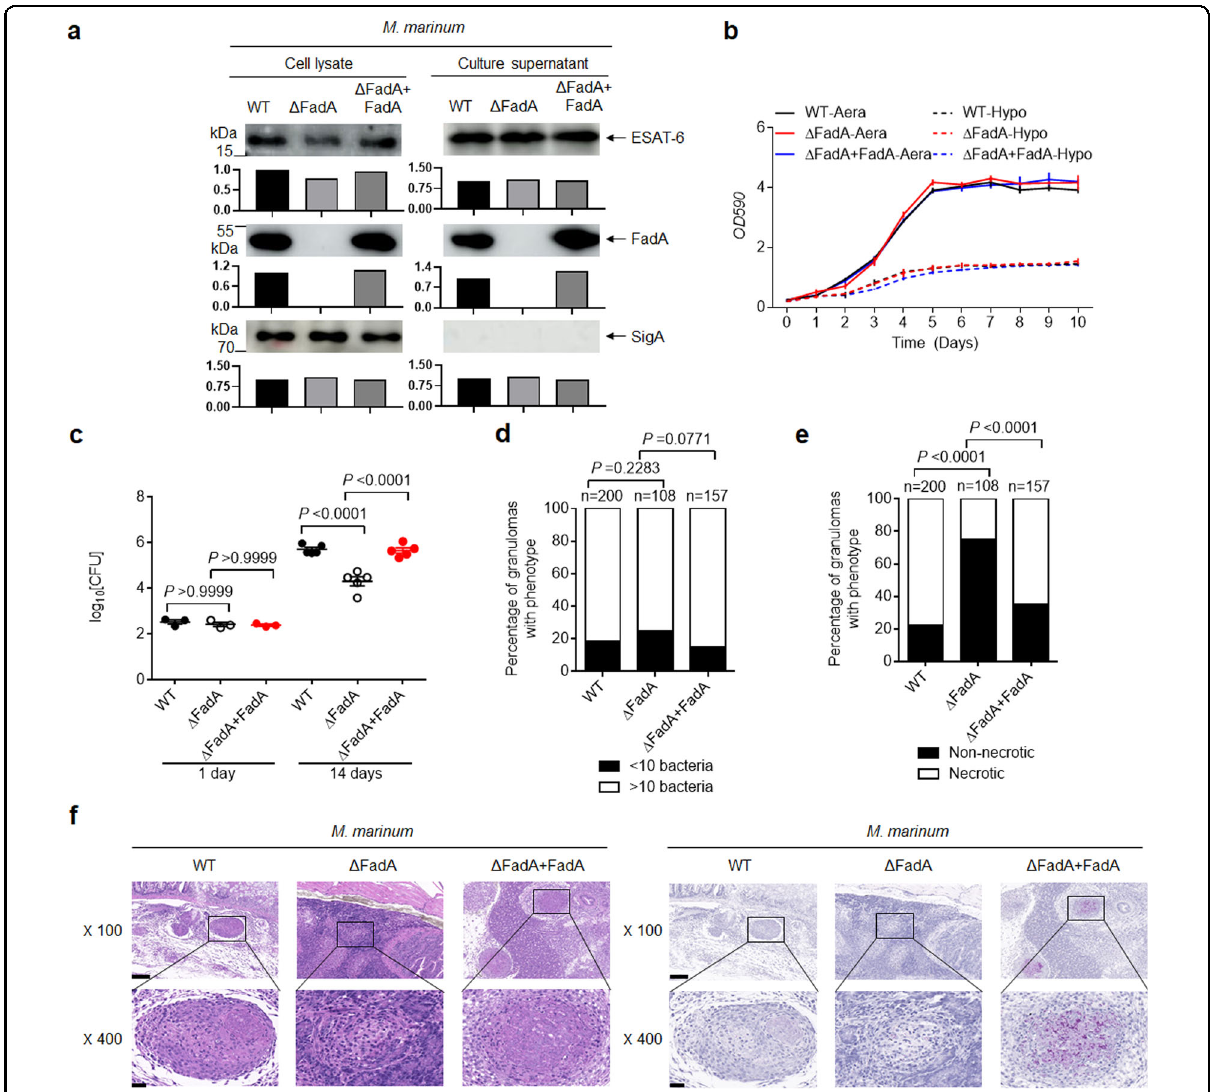
Fig. 2 FadA enhances the survival of mycobacteria in granulomas. a IB of cell lysate and culture fi ltrate of WT, Δ FadA, or Δ FadA + FadA M. marinum strains with anti-FadA, anti-ESAT-6, and anti-SigA antibodies at a 1:1000 dilution. Bars represent densitometric analysis of band intensity. Results are representative of three independent experiments. b Growth curve for in vitro growth of WT, Δ FadA, or Δ FadA + FadA M. marinum strains under aeration or hypoxia at 30 °C for 10 days. c – f Adult zebra fi sh were intraperitoneally infected with roughly 200 CFU per fi sh of WT, Δ FadA, or Δ FadA + FadA M. marinum strains for 1 or 14 days. Histopathology was assessed in the whole fi sh sections with bacterial titers ( c ; mean ± SEM of n = 3 fi sh infected for 1 day or n = 5 fi sh infected for 14 days), comparison of granulomas between WT, Δ FadA, or Δ FadA + FadA M. marinum -infected adult zebra fi sh scored for M. marinum burden as less than 10 or 10 or more bacteria ( d ), or percentage of necrotic granulomas in each fi sh ( e ) and H&E or acid-fast staining from zebra fi sh infected for 14 days ( f ; scale bar, 100 μ m (top) and 20 μ m (bottom)). “ n ” in d , e was the total number of granulomas for each strain infected fi sh. A total number of zebra fi sh analyzed: fi ve (WT), fi ve ( Δ FadA), fi ve ( Δ FadA + FadA). Data in b – f represent one experiment with at least three independent replicates. One-way ANOVA with Bonferroni ’ s multiple comparisons test ( c ) and Fisher ’ s exact test ( d , e ) was used for statistical